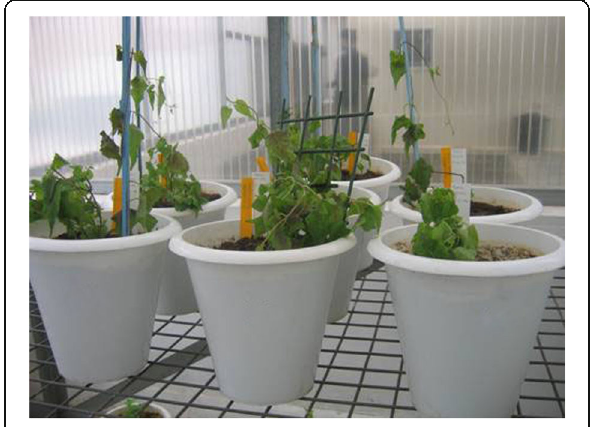
Fig. 1 Indian Mikania micrantha plants, infected with the Peruvian pathotype of Puccinia spegazzinii , transplanted into pots in the quarantine upon arrival from